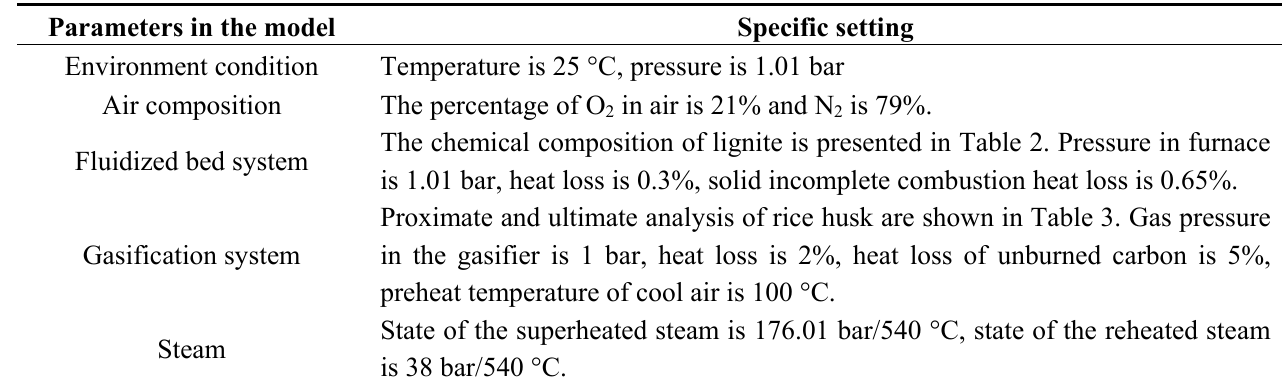
Table 1. Simulation model parameters.